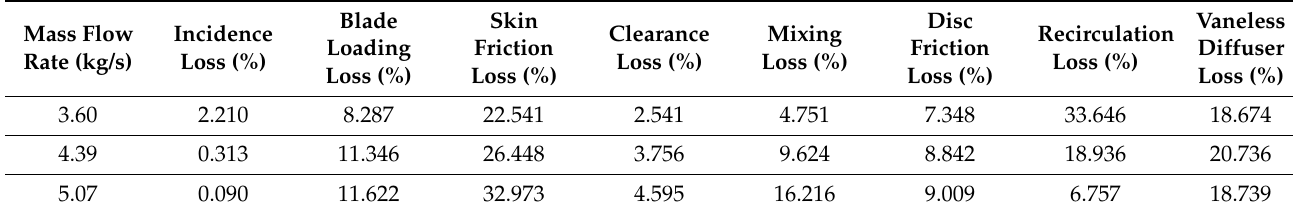
Table 4. Contributions of different losses for the HPCC case at 100% speed.